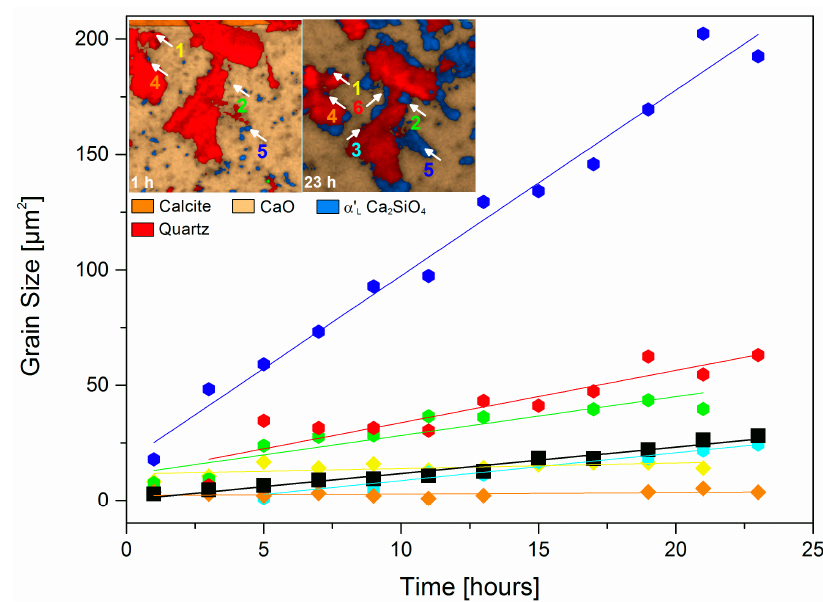
Figure 15. The growth of individual grains as a function of time. The average grain size (black squares) increases linearly with increasing sintering time which corresponds to a pseudo-zero-order behavior. In addition, the size of most single grains (colored hexahedron, grain 2, 3, 5, 6) increases linearly with time. The lines represent linear least-squares fits to the data. Image size in the inset is 100 × 100 µm 2 .